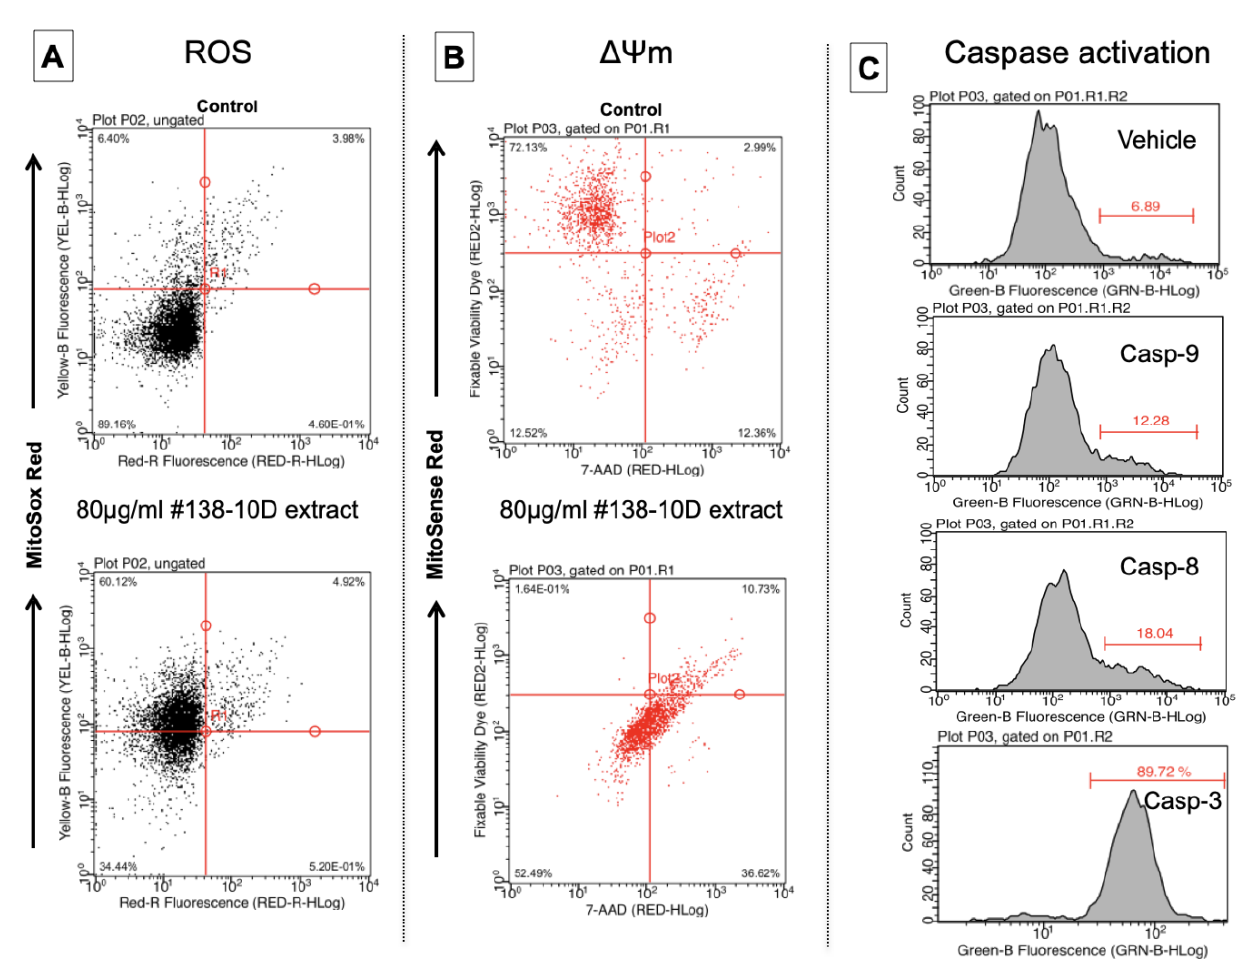
Figure 6. Detection of mitochondrial ROS generation, Mitochondrial potential, and Caspase activation in pancreatic tumor cells. Cells were exposed to 80 µ g/mL of #138-10D then incubated with specific dyes as described in M and M. ( A ) Analyzed data after incubation with a Flowcellect MitoSOX Kit. Dot plots show the percentage of unlabeled cells (Top left—ROS − ) or labeled cells (Bottom left—Ros + ) that showed an increase in yellow fluorescence. ( B ) Analyzed data after staining with Mitopotential Red Kit. Quadrant gates show downward shift in fluorescence for treated cells undergoing a change in their mitochondrial potential (lost their integrity). ( C ) Histograms show the percentage of positively stained cells by FITC green fluorescence (a shift to the right represents activation of caspase-3, 9 or